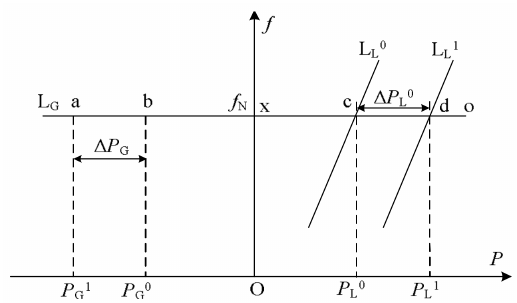
Figure 6. S-L analysis method of infinite power grid single-supply